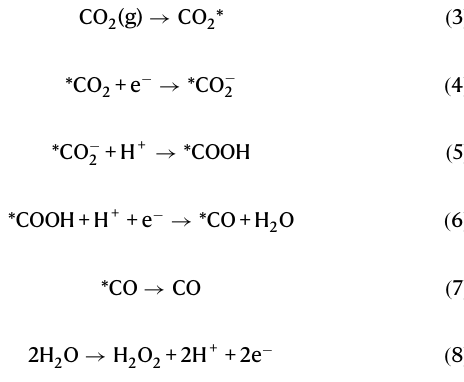
Fig. 5 | Overall photocatalytic CO 2 reduction performance of TMOF − 10-NH 2 . a Time courses of CO evolution by photocatalytic CO 2 reduction with water vapor using TMOF-10-NH 2 as photocatalysts under AM1.5G simulated sunlight. b Time courses of photocatalytic CO 2 reduction using TMOF-10-NH 2 (I) for 12h, with eva- cuation every 4h. Error bars represent the standard deviations of photocatalytic performance based on three independent samples. c Long-term photoreduction